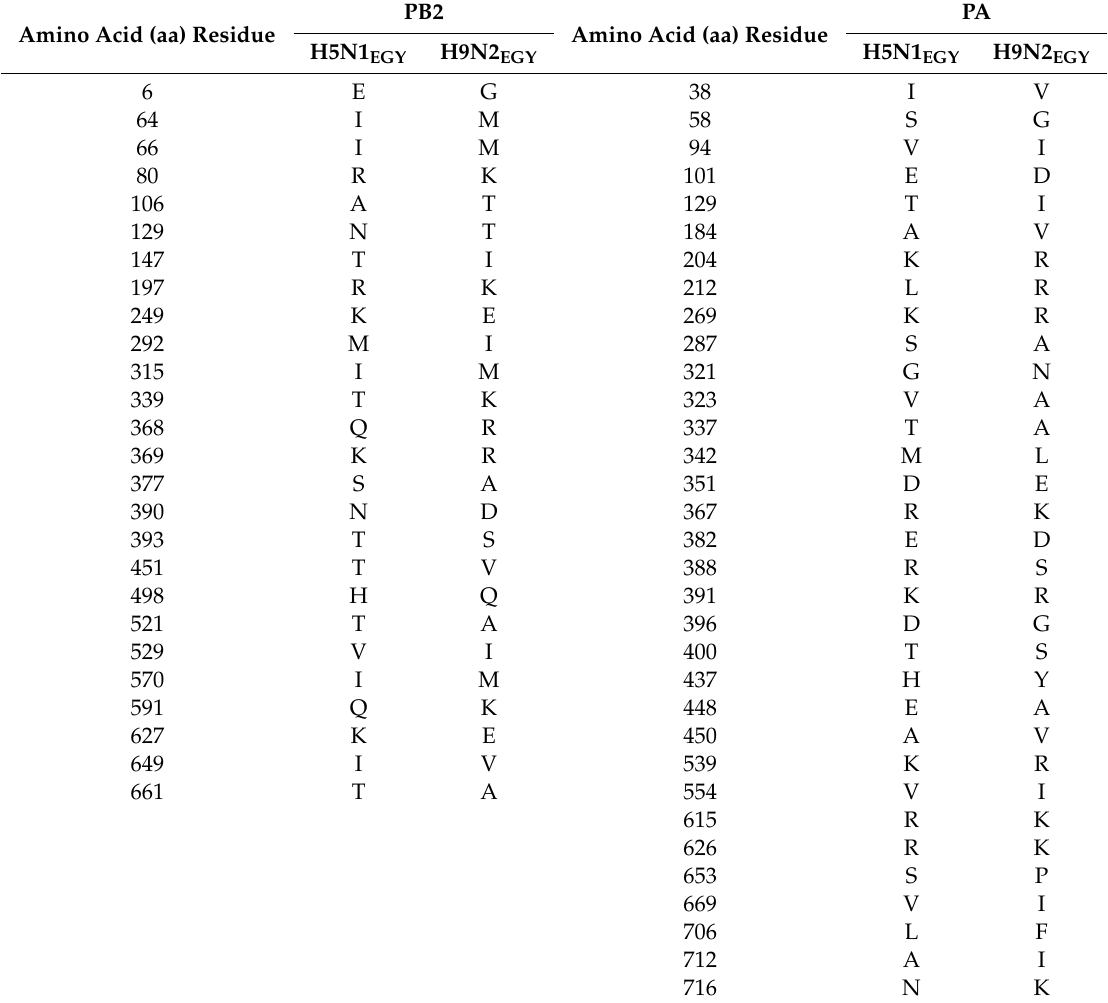
Table 2. Amino acid di ff erences between PB2 and PA proteins from H5N1 EGY and H9N2 EGY .